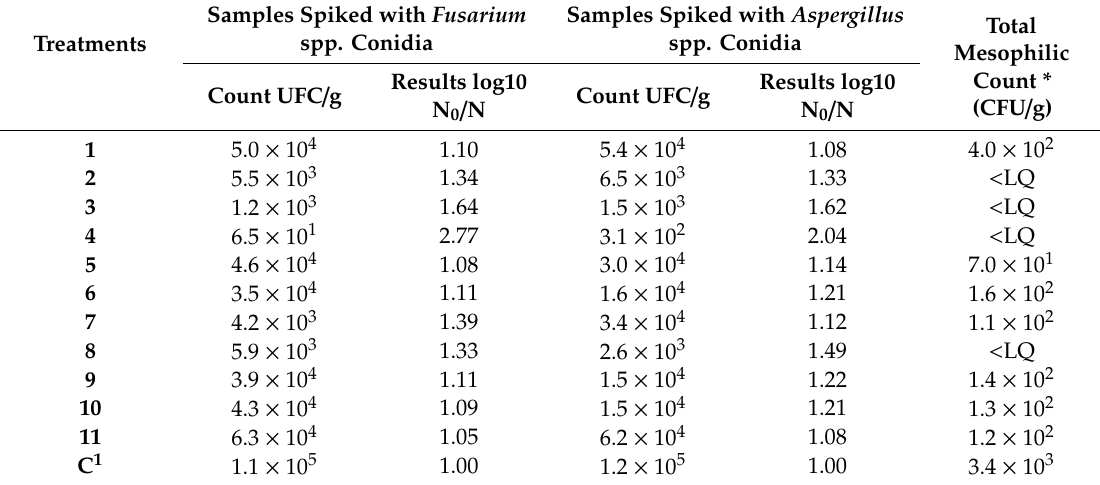
Table 2. Total fungal and mesophilic bacteria counts in the corn grit samples after exposure to di ff